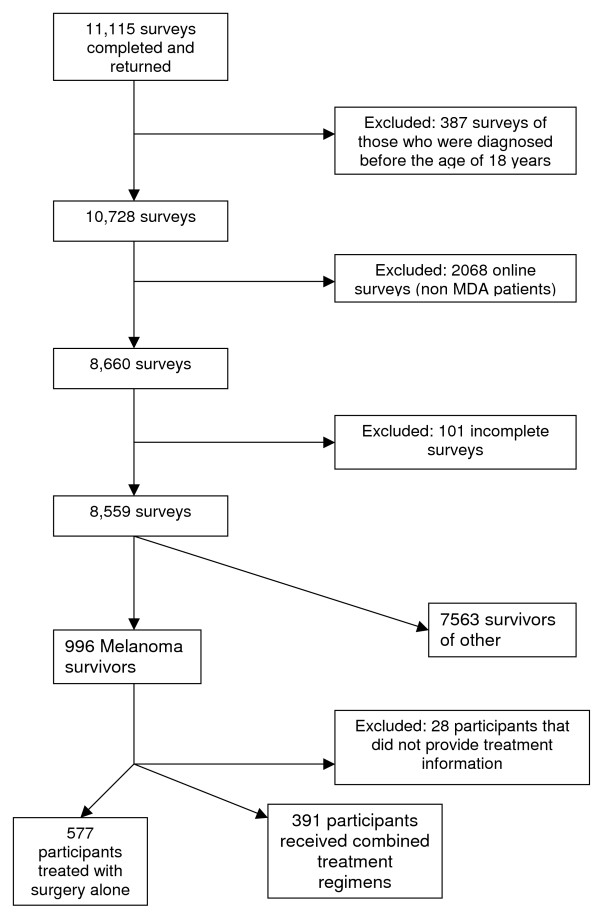
Filtering of Study Population.